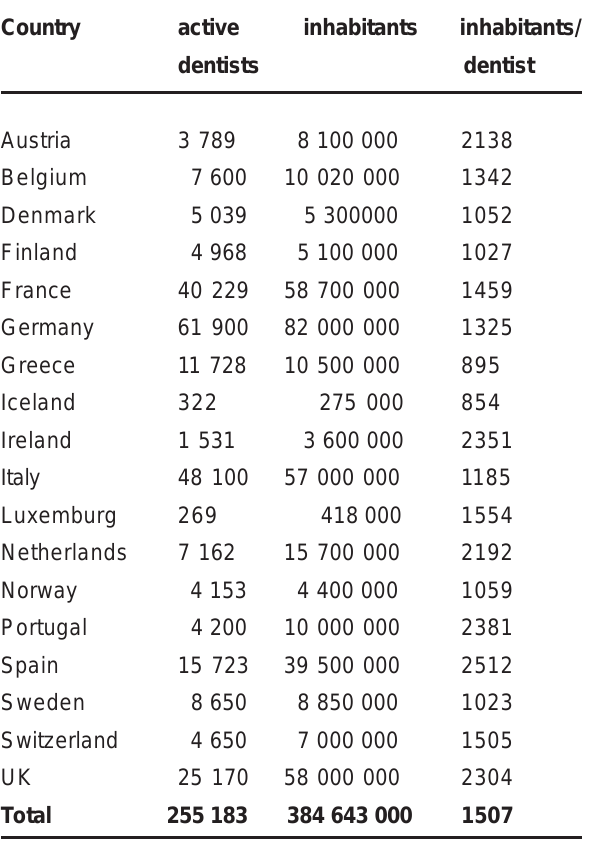
TABLE 3- Dentist density in various European